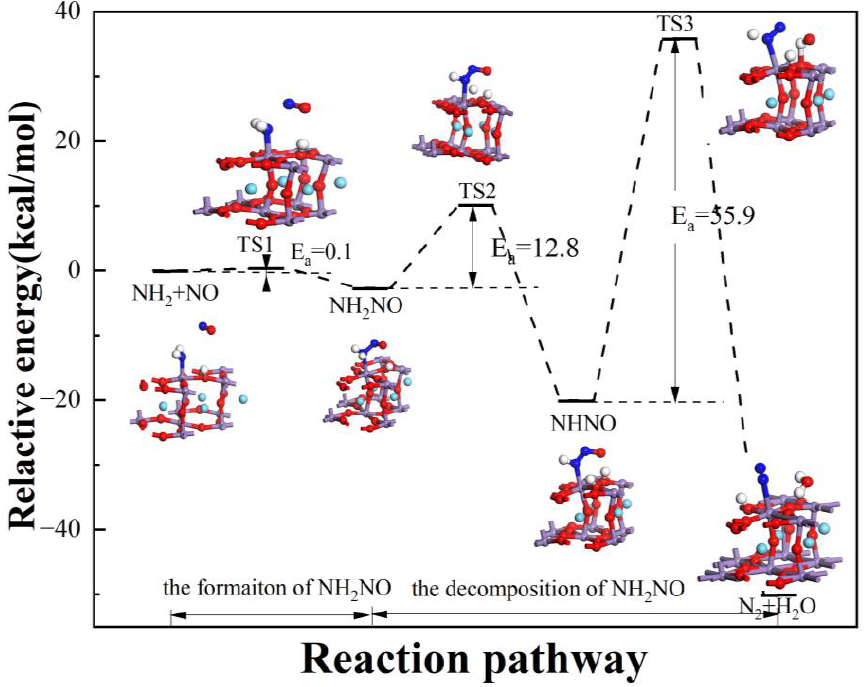
Figure 5. The reaction process of NH 2 NO formation and decomposition reaction over catalyst.